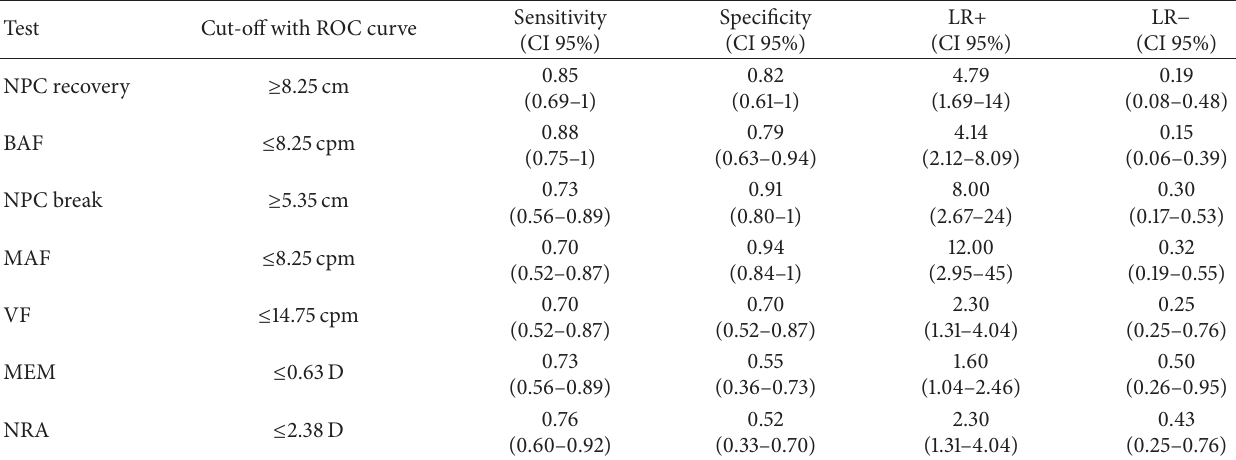
Table 4: Diagnostic validity for each test using cut-offs obtained with ROC curves.